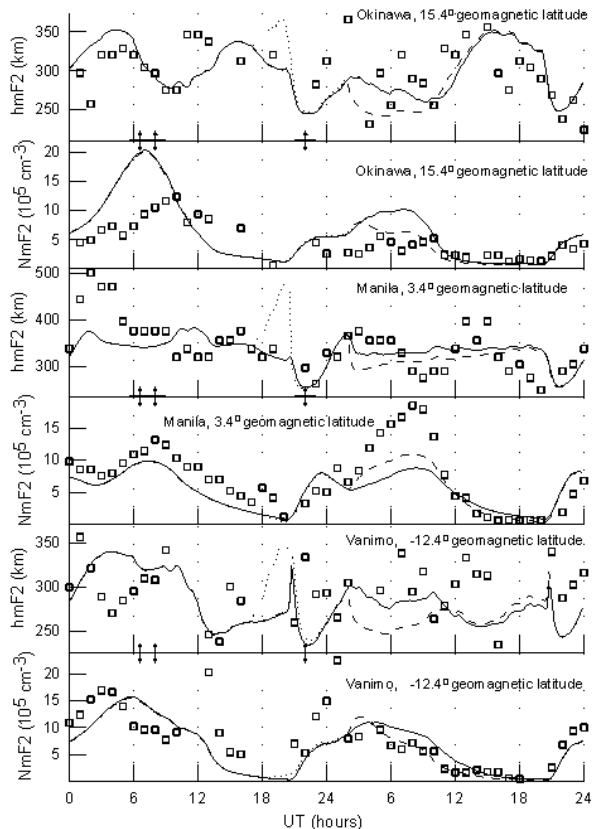
Fig. 3. Observed (squares) and calculated (lines) NmF 2 and hmF 2 during 25–26 August 1987 over the Vanimo (two bottom panels), Manila (two middle panels), and Okinawa (two top panels), The solid lines show the calculated NmF 2 and hmF 2 using the storm- time corrected (crosses in the bottom and middle panels of Fig. 1) zonal electric field, while the dotted lines are NmF 2 and hmF 2 from the model with the uncorrected (solid lines in the bottom and middle panels of Fig. 1) zonal electric field. To produce the model results shown by the dashed lines, the storm-time corrected zonal electric field shown by crosses in the middle and bottom panels of Fig. 1 was divided by a factor of 10 at all the studied geomag- netic latitudes from 02:00 UT to 10:00 UT on 26 August 1987. The original HWW90 wind and NRLMSISE-00 neutral tempera- ture and densities are used in the model calculations. The start times of the sudden commencement (06:58 UT on 25 August), main phase (08:00 UT on 25 August) and recovery phase (22:00 UT on 25 Au- gust) of the geomagnetic storm are indicated by the